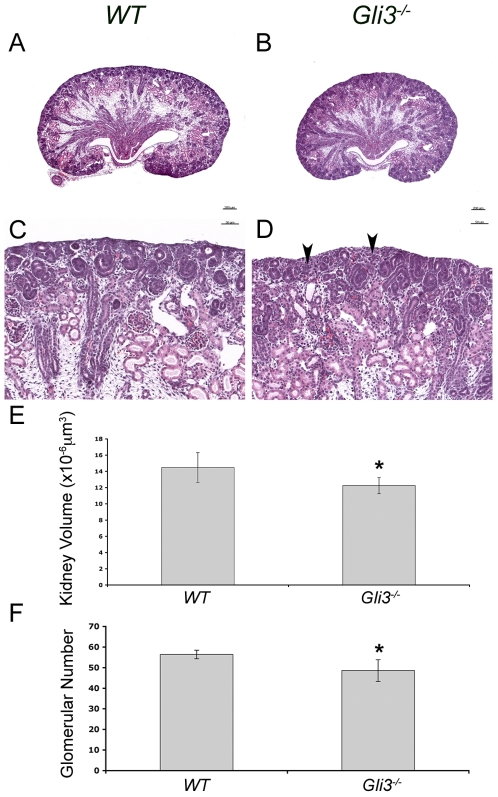
Loss of GLI repressor results in renal hypoplasia.(A–F) Analysis of Gli3−/− kidneys E18.5. Histological analysis of Gli3 deficient kidneys revealed a reduction in kidney size (A,B) and a reduced density of the nephrogenic zone (C,D). (E) Kidney volume was reduced by 15% in Gli3-deficient kidneys (p<0.05). (F) The number of mature glomeruli was reduced by 15% in Gli3-deficient kidneys (p<0.05).